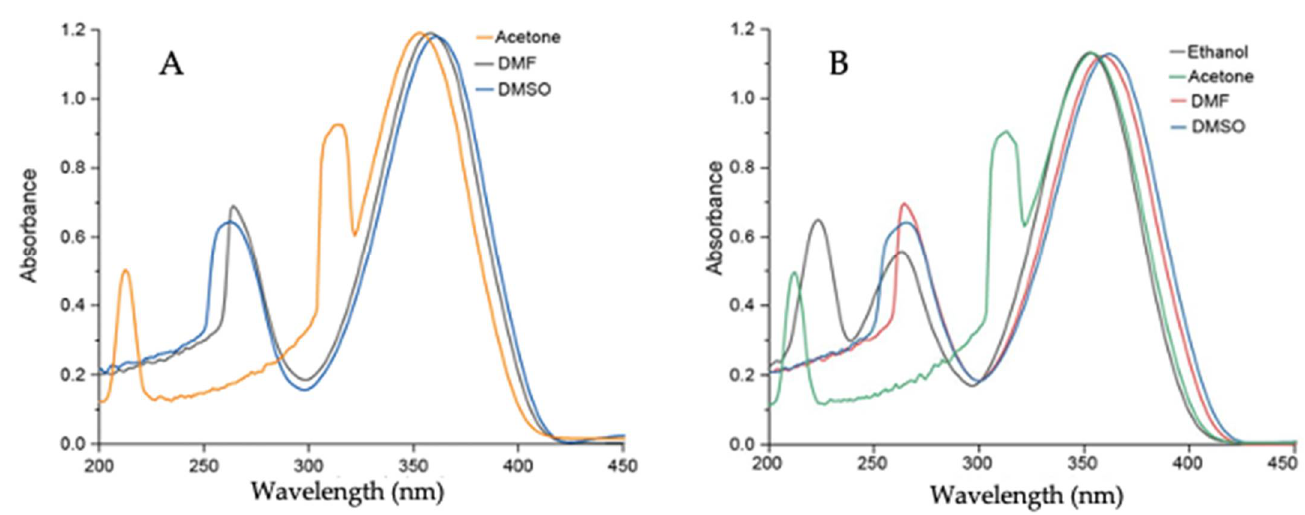
Figure 8. UV–vis spectrum of ( A ) Comp1 (0.5 × 10 −5 M) in DMF and DMSO; ( B ) Comp2 (0.5 × 10 −5 M) in acetone, ethanol, DMF, and DMSO.